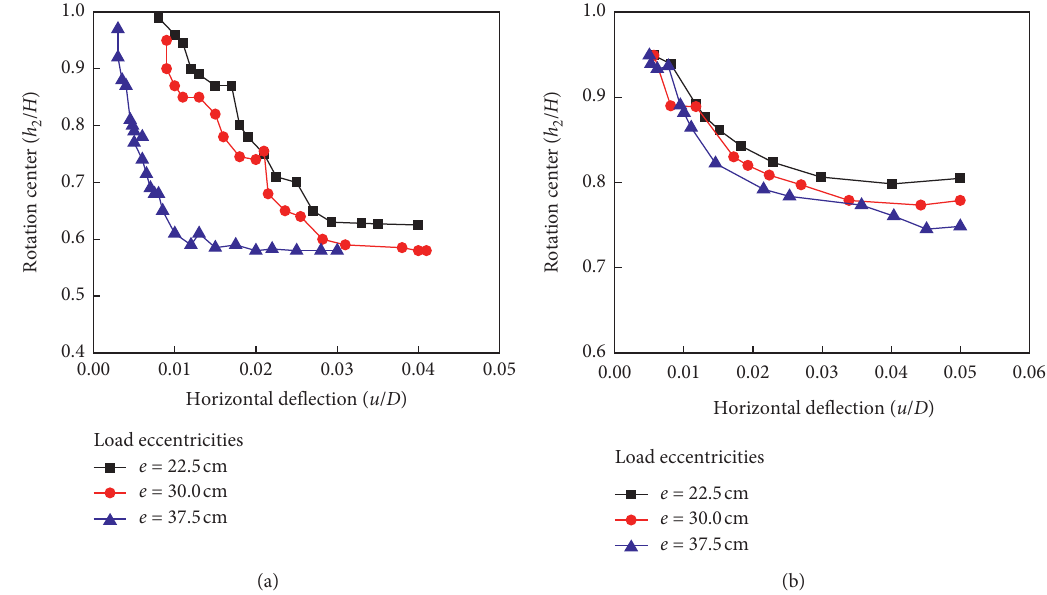
Figure 12: Rotation center distribution in the embedded depth. (a) For the CHFRF no. II-D. (b) For the circular gravity-based foundation.